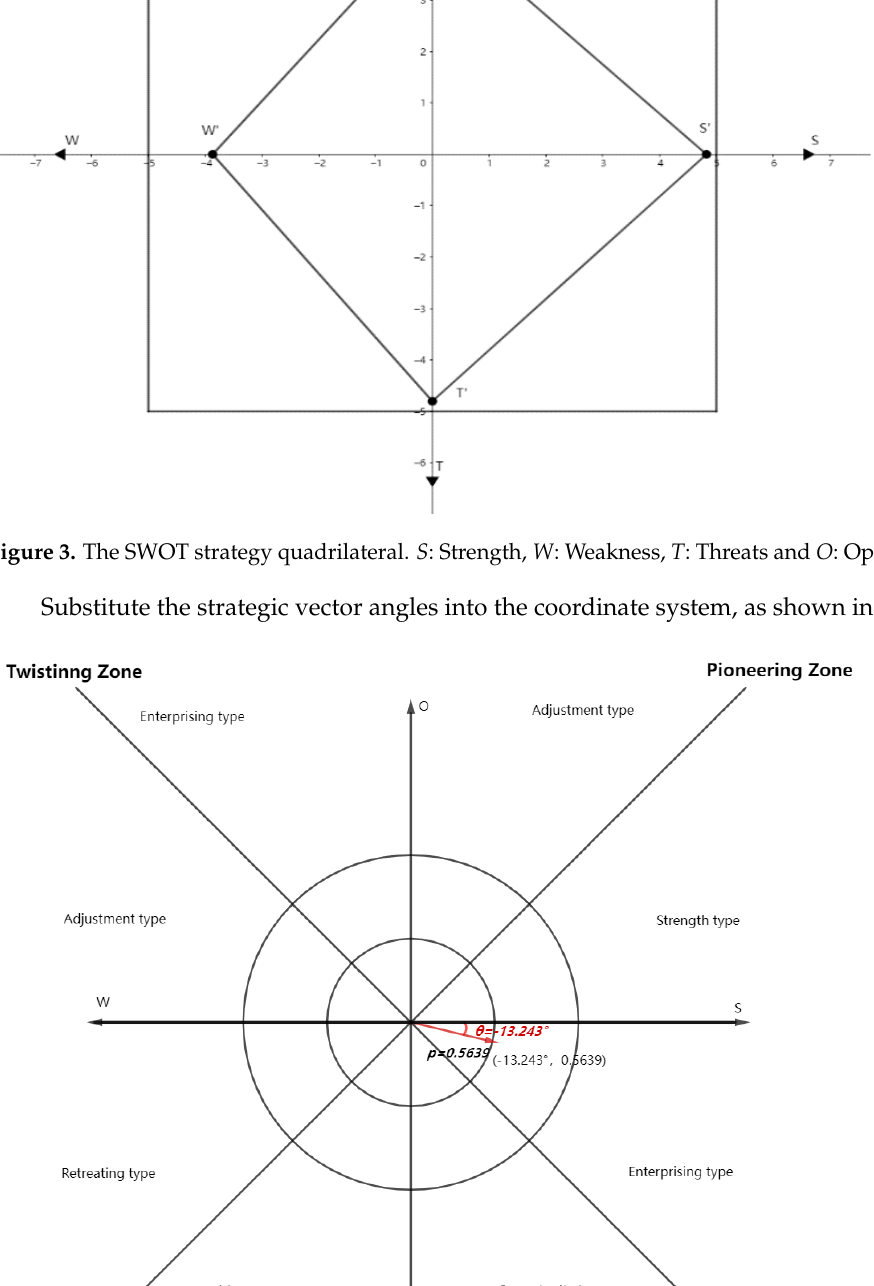
Figure 4. Development strategy vector and interval maps. S : Strength, W : Weakness, T : Threats and O :